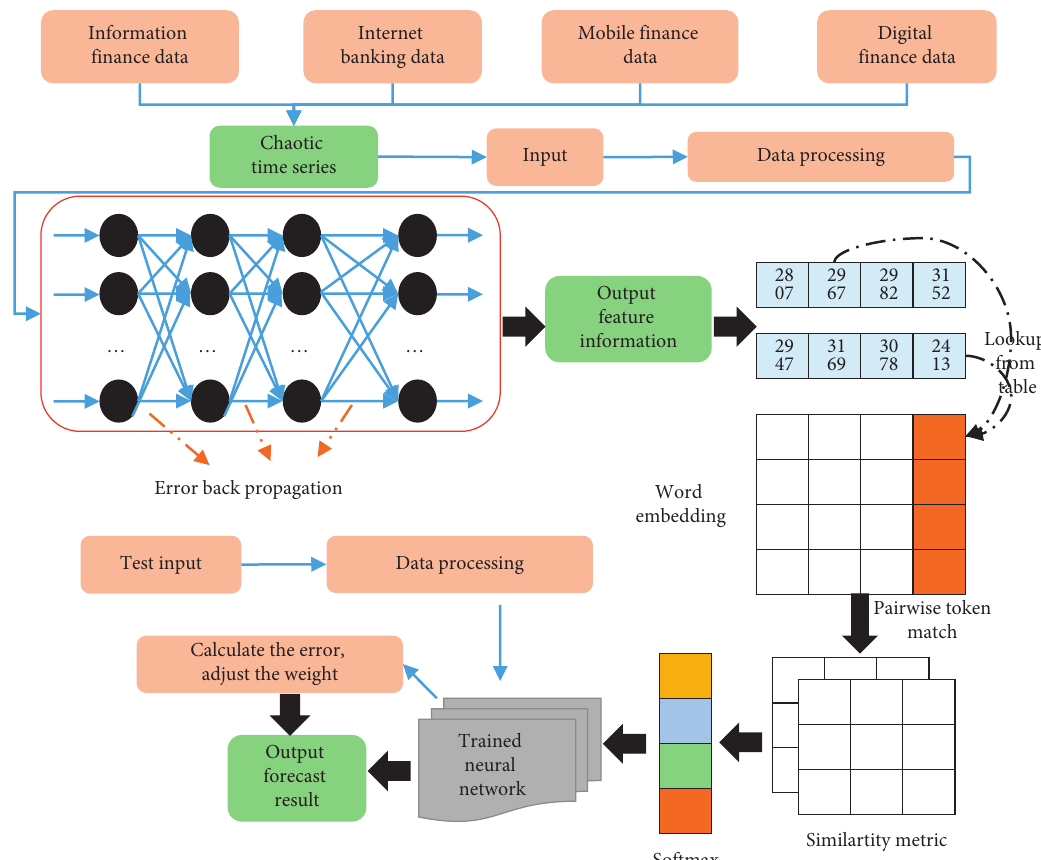
Figure 2: The improved BP neural network structure in this